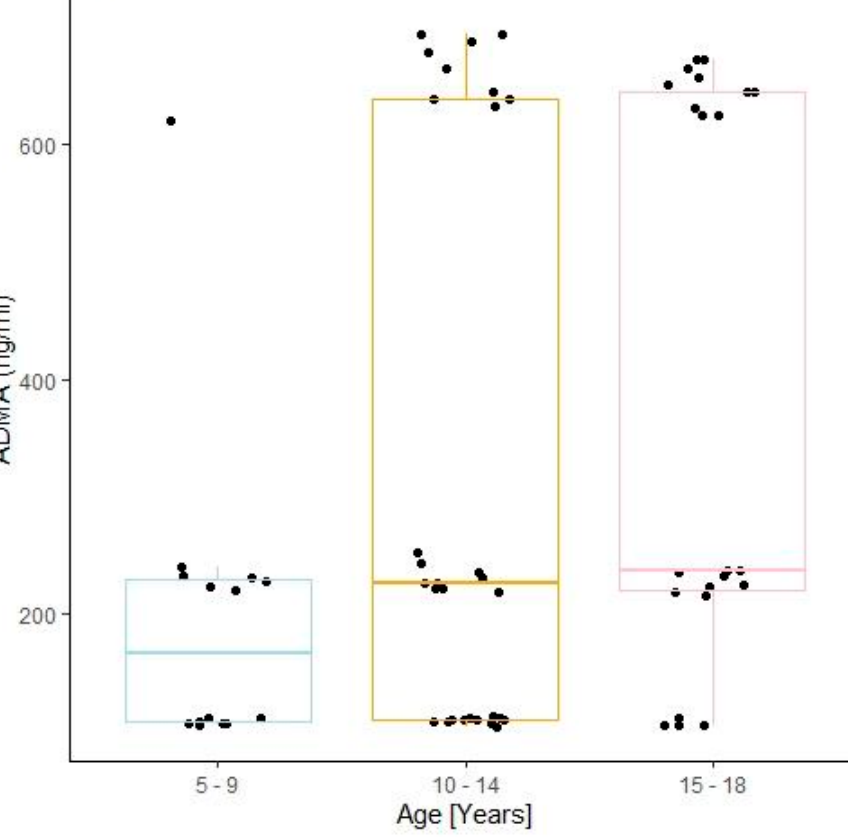
Figure 2. A comparison of the ADMA values depending on the patient’s age (196.99 ± 135.66 vs. 331.71 ± 246.17 vs. 397.40 ± 238.84 ng/mL). Boxplot of values for each subgroup. Legends: patients aged 5–9-years-old, n = 14; patients aged 10–14-years-old, n = 30; patients aged 15–18-years-old, n = 22.